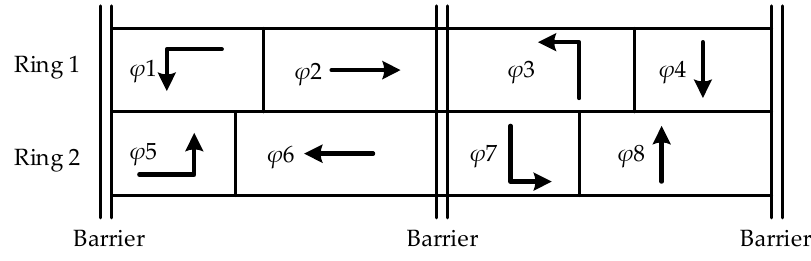
Figure 1. The standard NEMA dual-ring controller diagram.